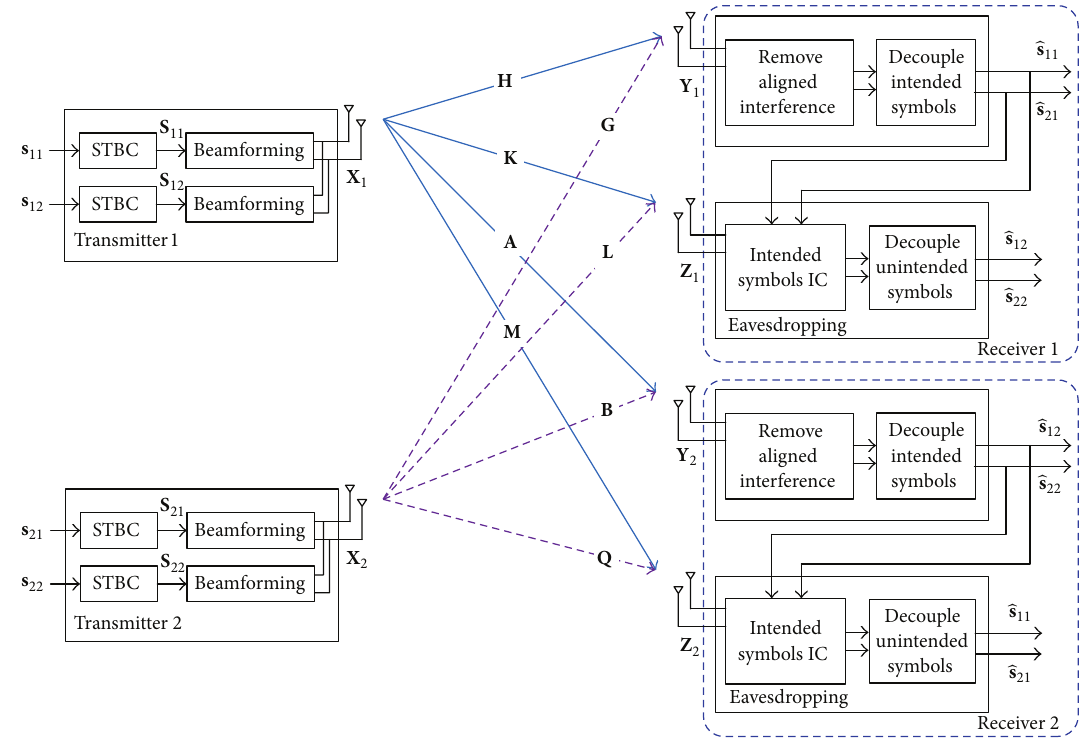
Figure 1: System model of a 2-user X channel with